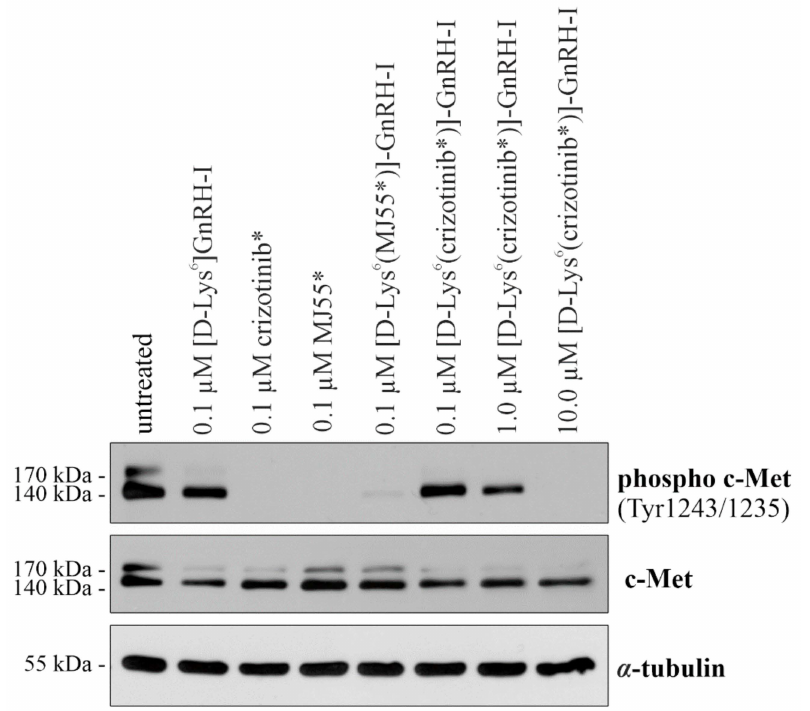
Figure 5. The c-Met inbibitory e ff ect of the compounds in EBC-1 cells. Cells were treated with [ d -Lys 6 ]–GnRH-I, crizotinib*, MJ55*, [ d -Lys 6 (crizotinib*)]–GnRH-I, and [ d -Lys 6 (MJ55*)]–GnRH-I Untreated cells and